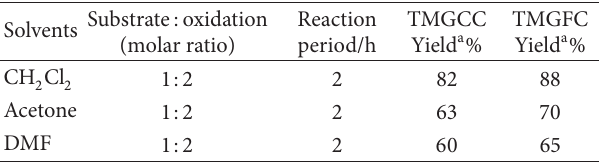
Table 1: Oxidation of benzyl alcohol with different amounts of TMGCC and TMGFC.